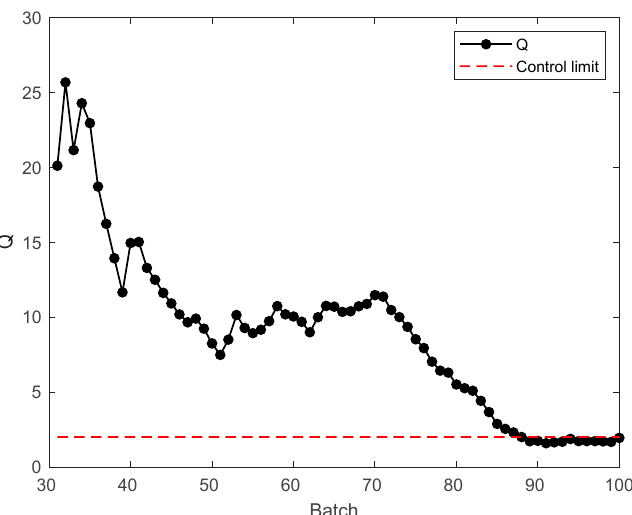
Figure 4. Product weights.